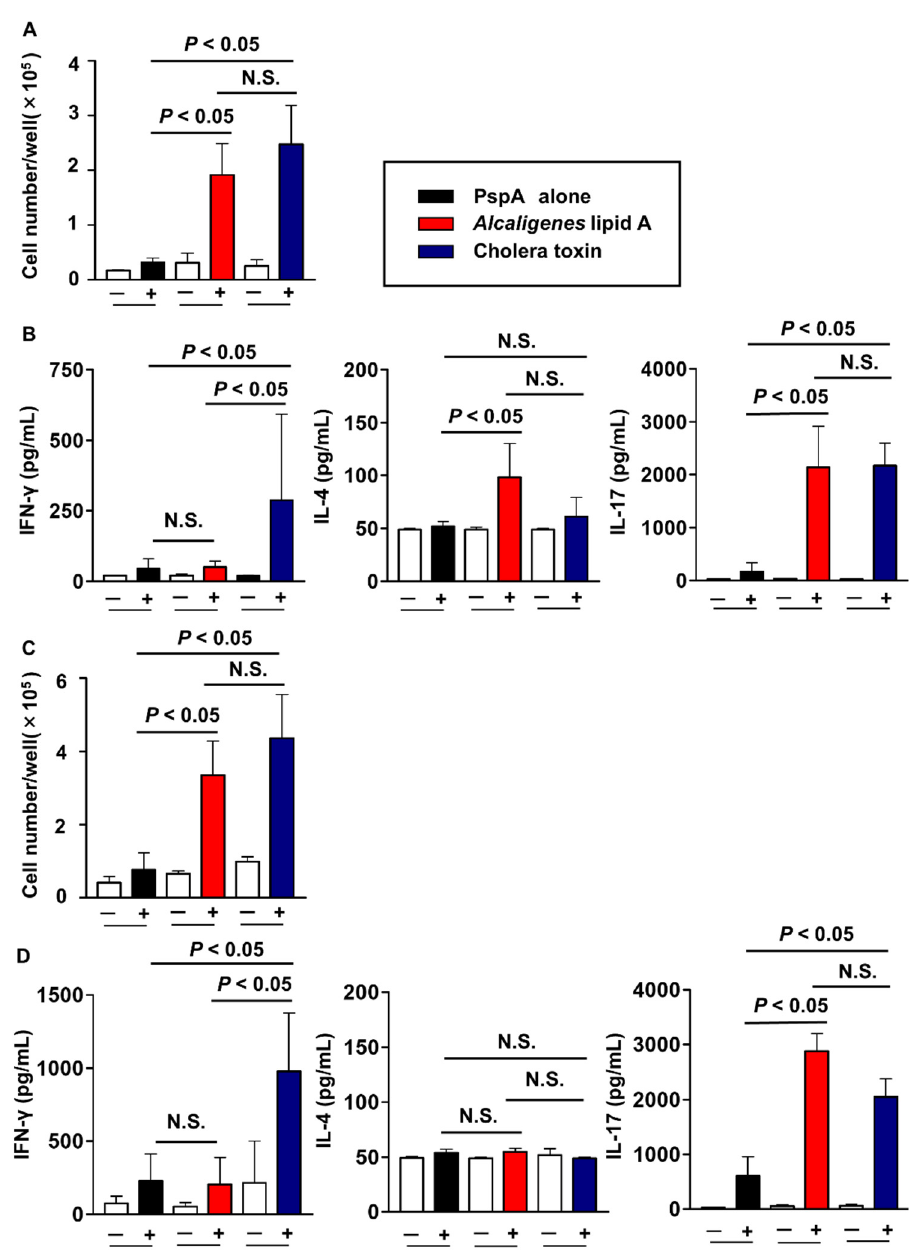
Figure 3. Preferential induction of Th17 responses in both respiratory and systemic compartments by nasal immunization with PspA together with Alcaligenes lipid A. Nasal immunization with PspA with or without Alcaligenes lipid A or cholera toxin, three times at one-week intervals. One week after the final immunization, CD4 + T cells were isolated from the cervical lymph nodes (CLNs) and spleen, and then cultured with irradiated antigen-presenting cells in the presence ( + ) or absence ( − ), respectively, of PspA. After 4 days, cultured cells were stained by using CyQUANT cell proliferation assay kits to calculate the numbers of proliferating T cells ( A , CLNs; C , spleen). Data were combined from two independent experiments and expressed as means ± SD ( n = 4 per group). The concentrations of IFN- γ , IL-4, and IL-17 in the culture supernatants were measured ( B , CLNs; D , spleen). Data are representative of two independent experiments and are expressed as means ± SD ( n = 4 per group). ( + ) and ( − ) indicate the presence or absence, respectively, of PspA during culture. Statistical significance was evaluated by using one-way ANOVA with p < 0.05; N.S., not statistically significant.